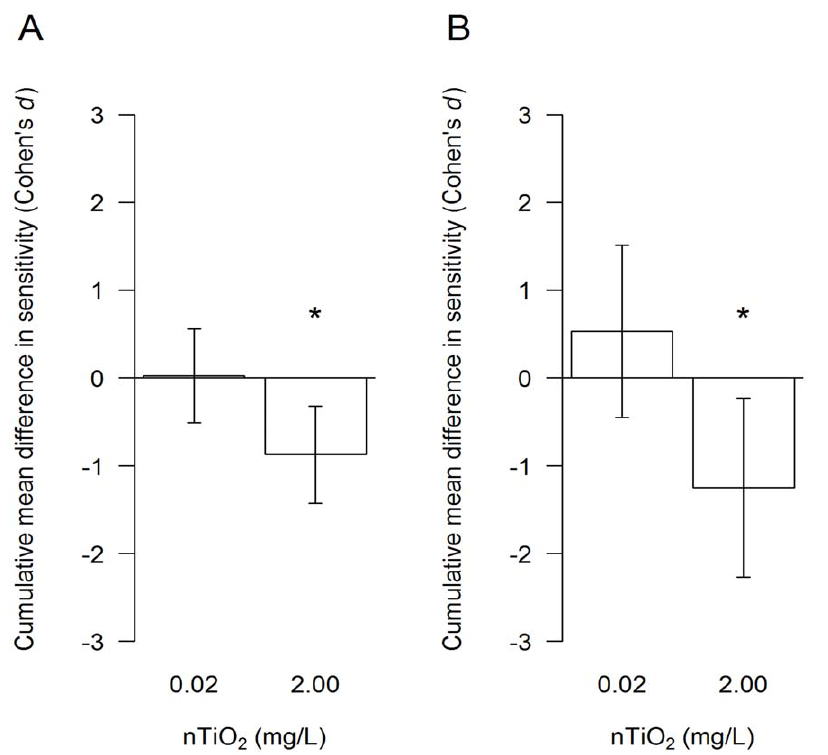
Figure 4. The sensitivity of juveniles released by nTiO 2 -exposed adults. The cumulative mean ( 6 95% CIs) difference in sensitivity – in terms of 96 h-EC50 values – of the offspring (fifth brood) released by adults exposed to 0.02 or 2.00 mg nTiO2/L and offspring released by control (uncontaminated) daphnids is displayed using the standardised effect size Cohen’s d . ( A ) The cumulative effect sizes for all bioassays conducted (n=7) with the fifth brood during the first and second set of experiments. ( B ) The cumulative effect sizes for acute toxicity experiments conducted with offspring released in the control medium by adults previously exposed to the above-mentioned nTiO2 concentrations during the second set of experiments (n=3). The statistical significance of a cumulative effect is highlighted by an asterisk (*). Negative effect sizes indicate increased toxicity.